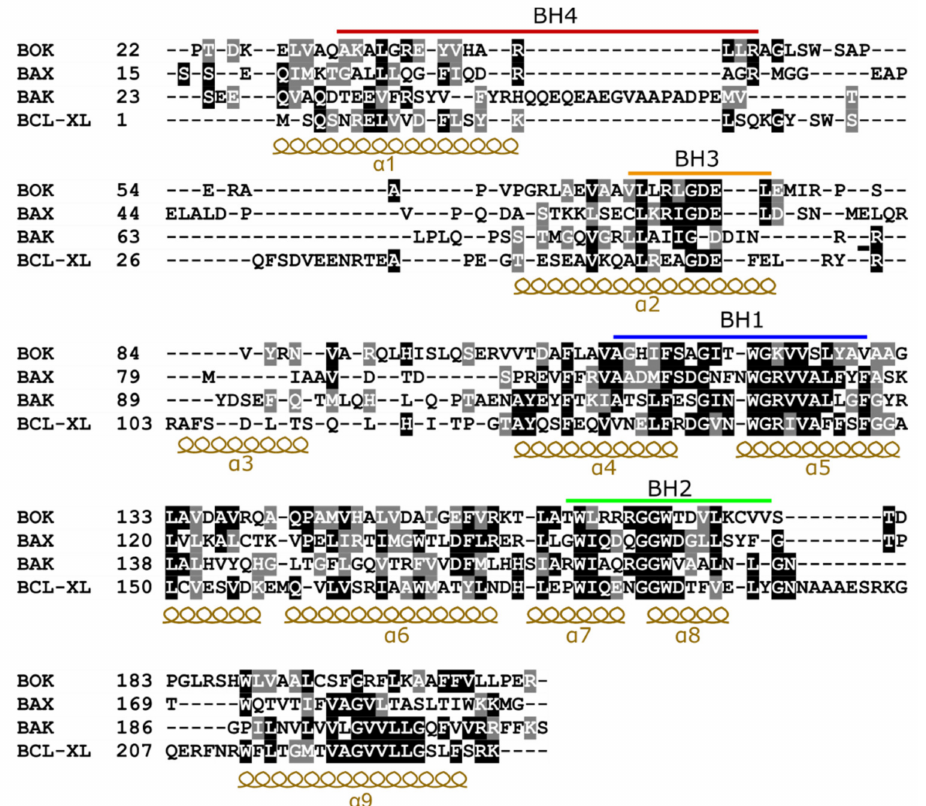
Figure 2. Structure-based sequence alignment of a subset of Bcl-2 family members. For aligning the sequences, the structure of BOK (PDB: 6CKV), BAX (PDB: 2K7W), BAK (PDB: 5FMI), and BCL-XL (PDB: 1BXL) were superimposed. The alignment was performed using UCSF Chimera software [32]. Identical residues are highlighted in black, while similar ones are highlighted in gray. The BCL-2 homology (BH) motifs are marked with bars and sequence regions corresponding to α -helices are indicated. The sequences of the transmembrane helix ( α 9) were aligned using Clustal Omega [33] as this region was not resolved in the